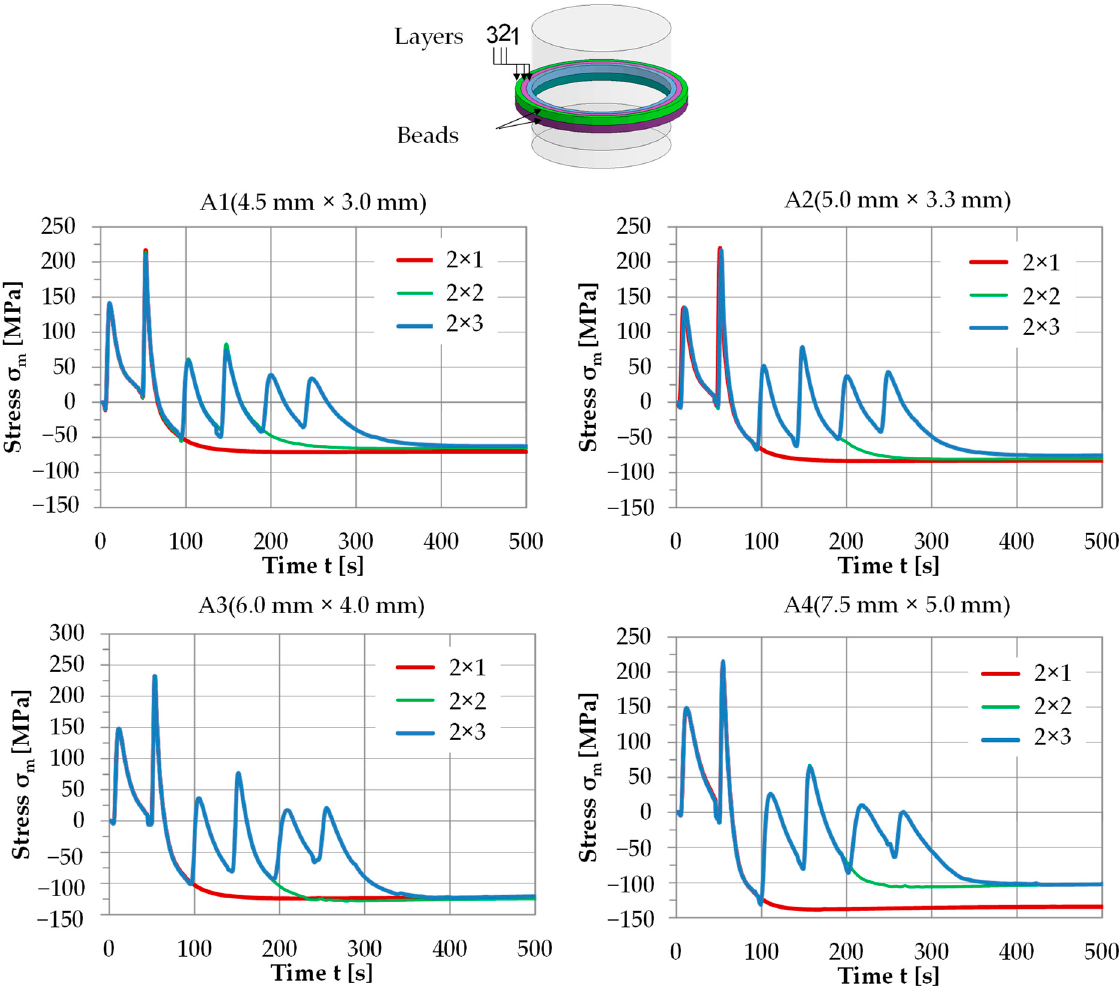
Figure 27. Comparison of the stress history of the tool-element in multiple layers welding with A1– A4 beads. A1–A4